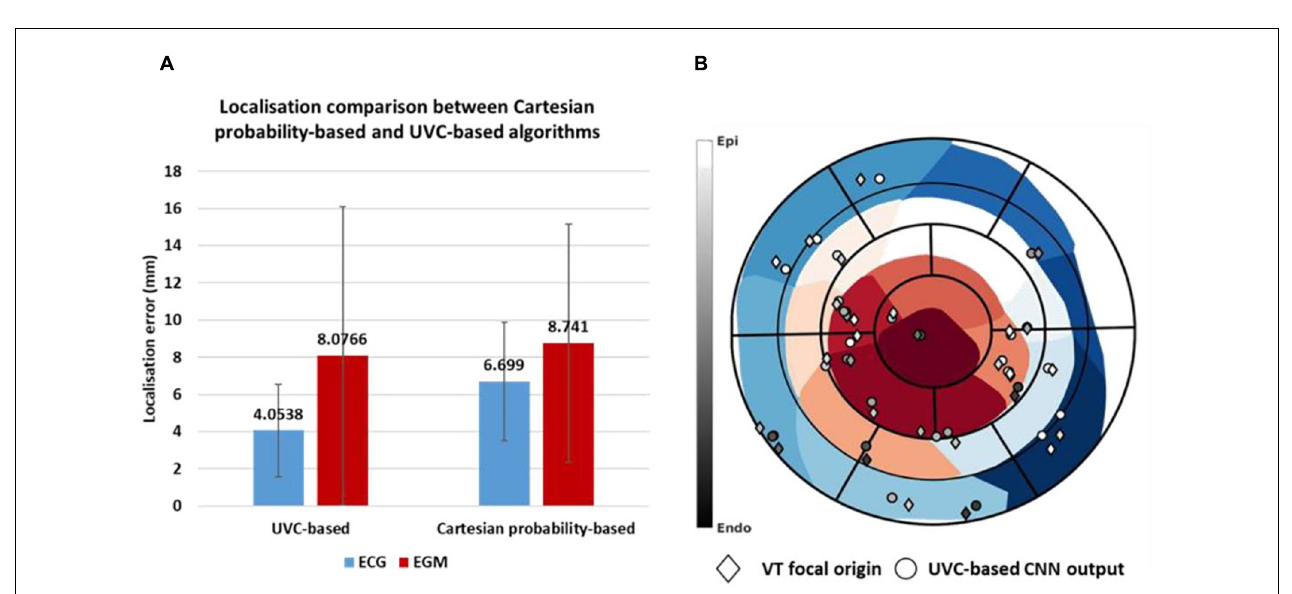
FIGURE 10 | Localization performance of Cartesian probability-based algorithm. Localization errors in millimeters are reported for ECG-based (blue) and EGM-based (red) testing. A comparison in localization performance between different Segment CNNs can also be seen; the 17-feature Segment CNN is on the left (A) and the 68-feature Segment CNN is on the right (B) .